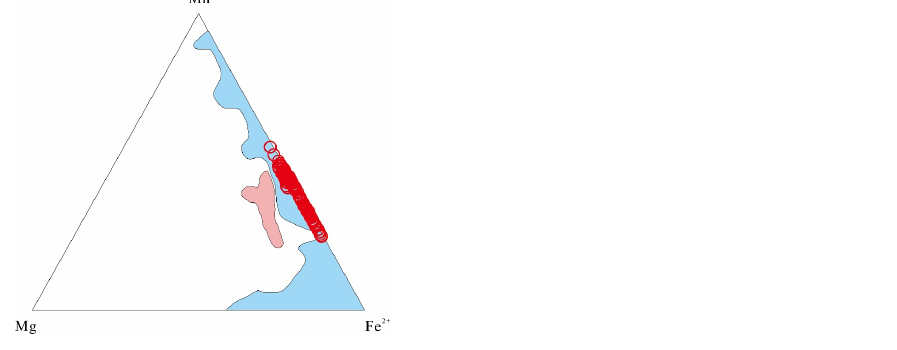
Figure 10. Mn – Mg – Fe ternary diagram. The pink area represents the magmatic garnet field from Figure 10. Mn–Mg–Fe ternary diagram. The pink area represents the magmatic garnet field S-type granite [21], and the light blue area represents the magmatic garnet field from [87]. Garnets from the muscovite granite and pegmatite fall in the field of magmatic garnet reported by [87].